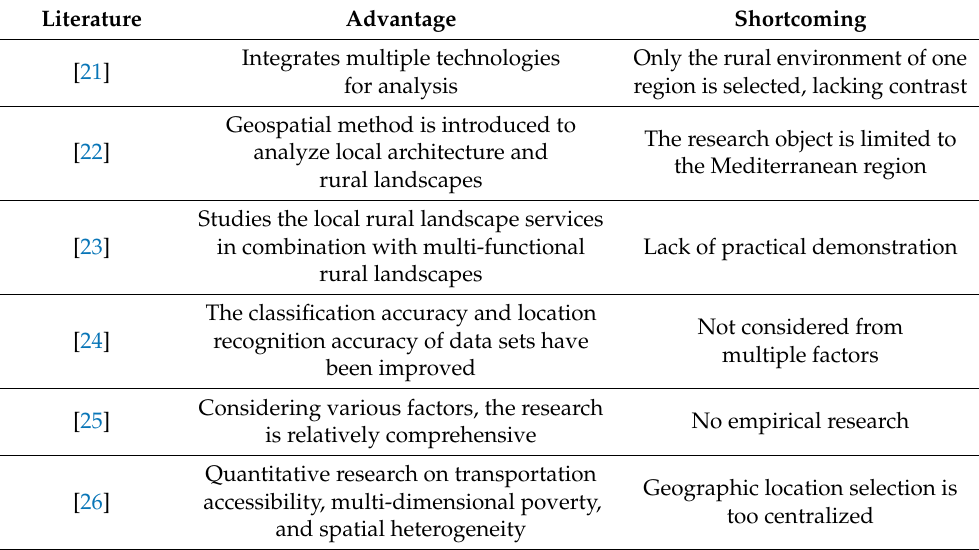
Table 1. Comparison of different literature